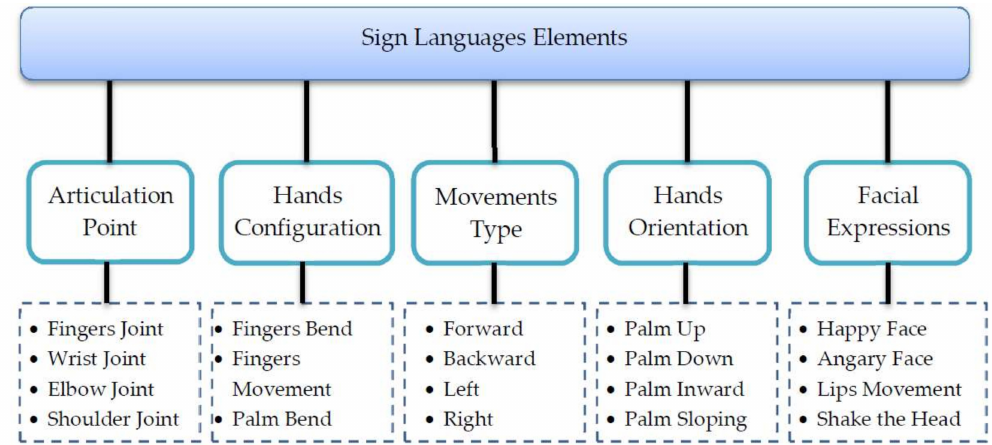
Figure 1. The essential elements related to sign language gesture